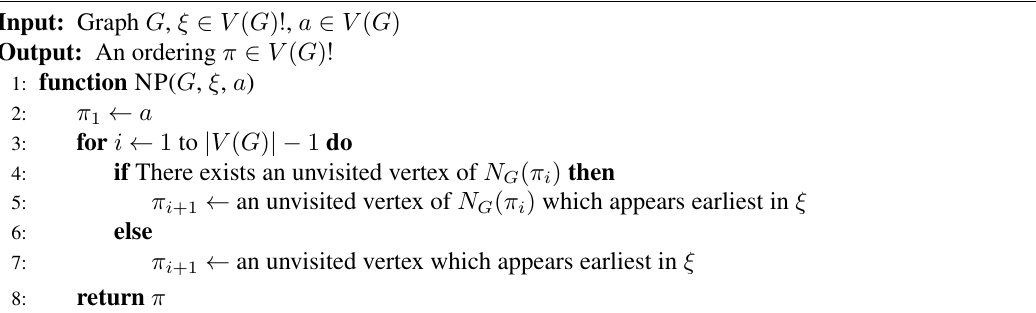
Algorithm 3.1 Find a special vertex ordering with a given starting point according to a given vertex